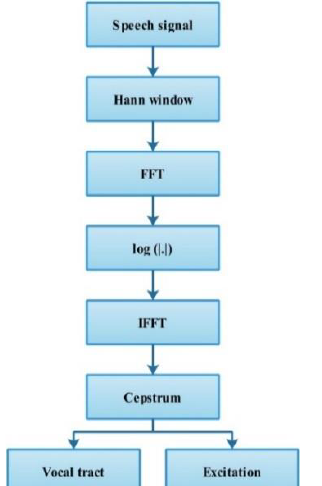
Fig. 1. The process of extracting the vocal tract and excitation cepstrum from the esophageal speech signal.